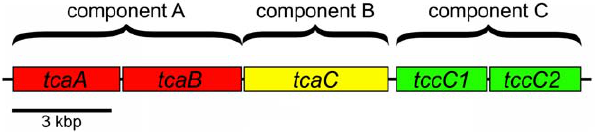
Figure 1. Organization of the tca operon as found in Bt isolate IBL